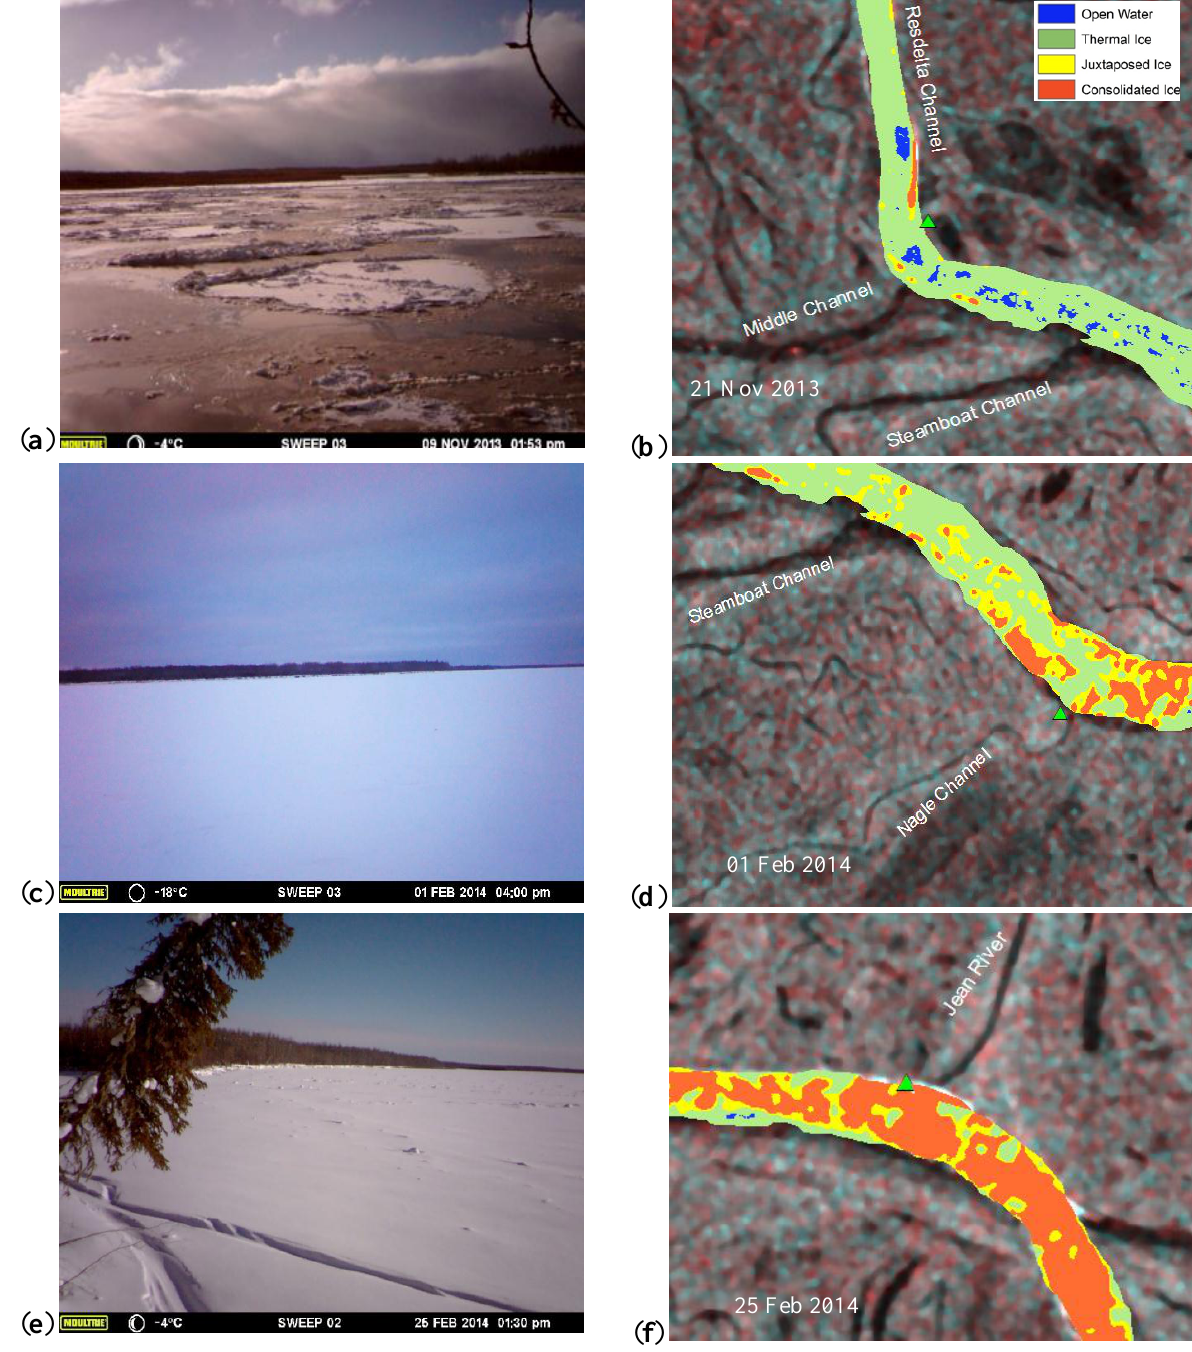
Figure 12. River ice covers from time-lapse camera ( left ) and remotely-sensed data ( right ), ( a ) & ( b )—ice cover between Steamboat Channel and Resdelta Channel, ( c ) & ( d )—ice cover between Nagel Channel and Steamboat Channel, ( e ) & ( f )—ice cover near Jean River. Location of time-lapse camera is shown in blue triangle. (RADARSAT-2 Data and Products © MacDonald, Dettwiler and Associates Ltd. (2013–2014)—All Rights Reserved. RADARSAT is an official trademark of the Canadian Space